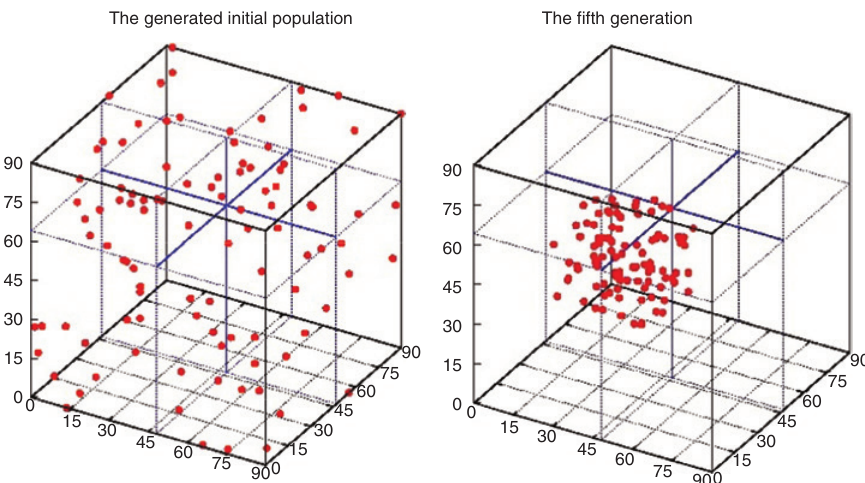
Figure 5: The initial population of 100 individuals and the fifth generation (BB-BC).